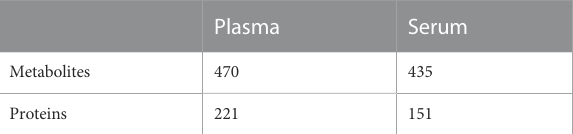
TABLE 1 Number of features with a signi fi cant effect from the factor individual .Shownisthenumberofsigni fi cantfeaturesafterFDRcorrection ( α < 0.05) for the factor individual by LIMMA analysis (see Methods for further details). The total number of features is 497 (metabolites) and 572